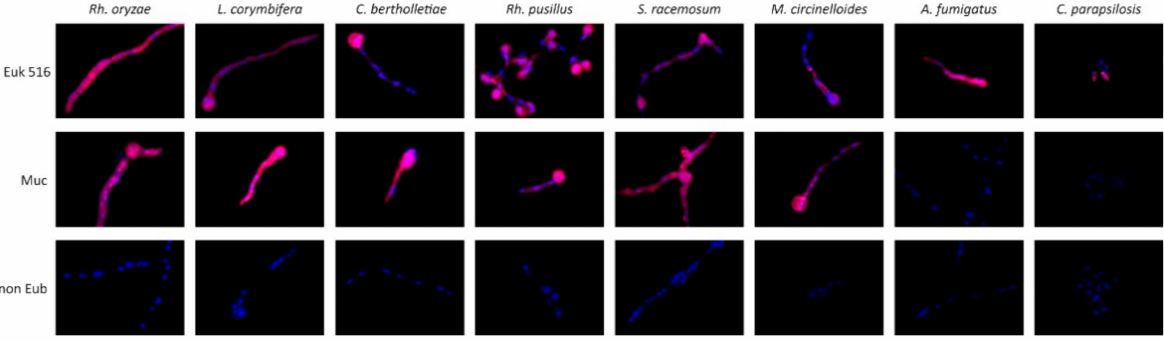
Figure 1. Evaluation of a combination of FISH probes selectively targeting the ribosomal RNA of agent germlings of frequent mucormycosis agents. Hybridization with the unspecific control probe targeting eukaryotic cells (Euk 516, upper) demonstrates a cytoplasmic signal of high intensity (upper row). Hybridization using a combination of probes targeting Mucorales demonstrates a cytoplasmatic signal comparable with the positive control but selective hybridization to Mucorales but not other selected agents of invasive fungal infections such as A. fumigatus and C. parapsilosis (central row). Hybridization with a nonsense probe (non Eub, lower row) demonstrating the absence of a fluorescence signal of fungal elements. All probes are coupled with Cy 5. Double stranded DNA stained with DAPI. Identical exposure times were used for each picture.